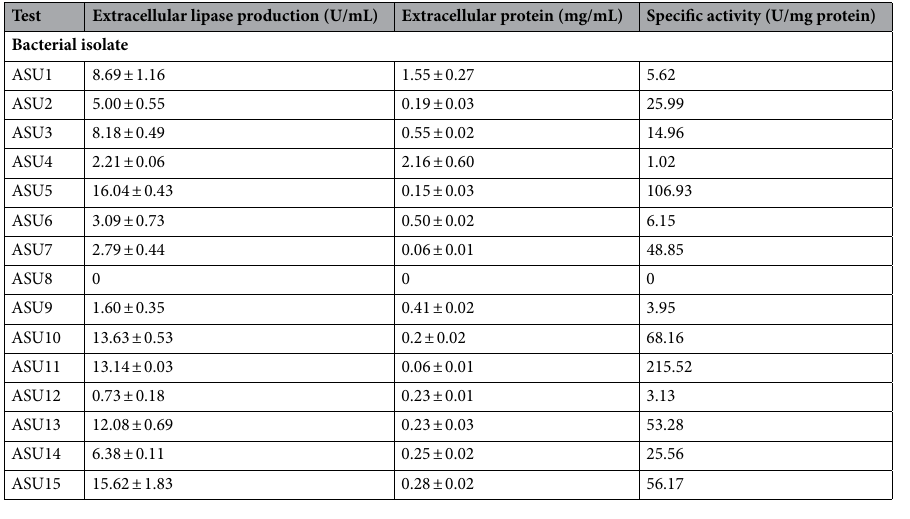
Table 2. Extracellular lipase production, extracellular protein, and lipase-specific activity of bacterial isolates. Each value represents the average of three replicates ±